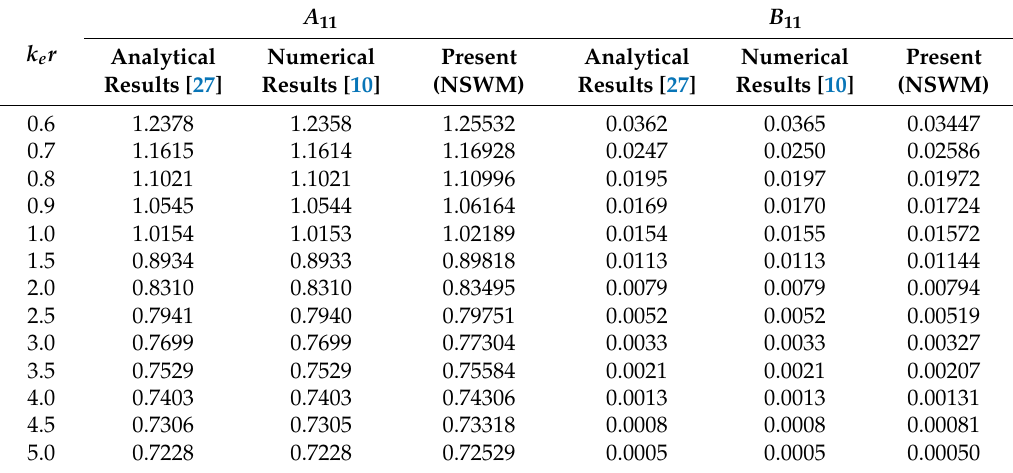
Table 3. Added masses and damping coe ffi cients of the sphere in surge motion ( Fr = 0.4, h = 2.0 r , k ec r = 0.3906).